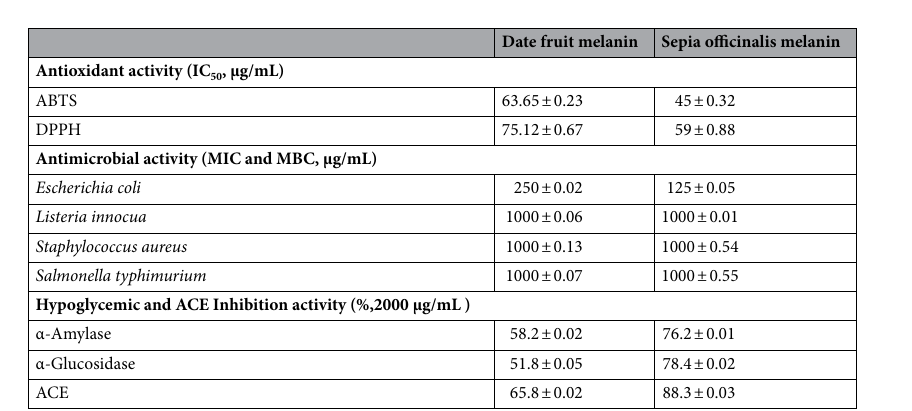
Table 1. Antioxidant (%) by DPPH and ABTS, and antimicrobial activity (%) of date fruit melanin and sepia melanin (Data represented as Mean ± SD). *IC 50 : half-maximal inhibitory concentration, MIC: Minimum inhibitory concentration, MBC: Minimum bacterial concentration, ABTS: 2,2 ′ -Azino- bis (3-ethylbenzthiazoline-6-sulfonic acid sulfonic acid), DPPH: 2,2-diphenyl-1-picrylhydrazyl, ACE: Angiotensin-converting